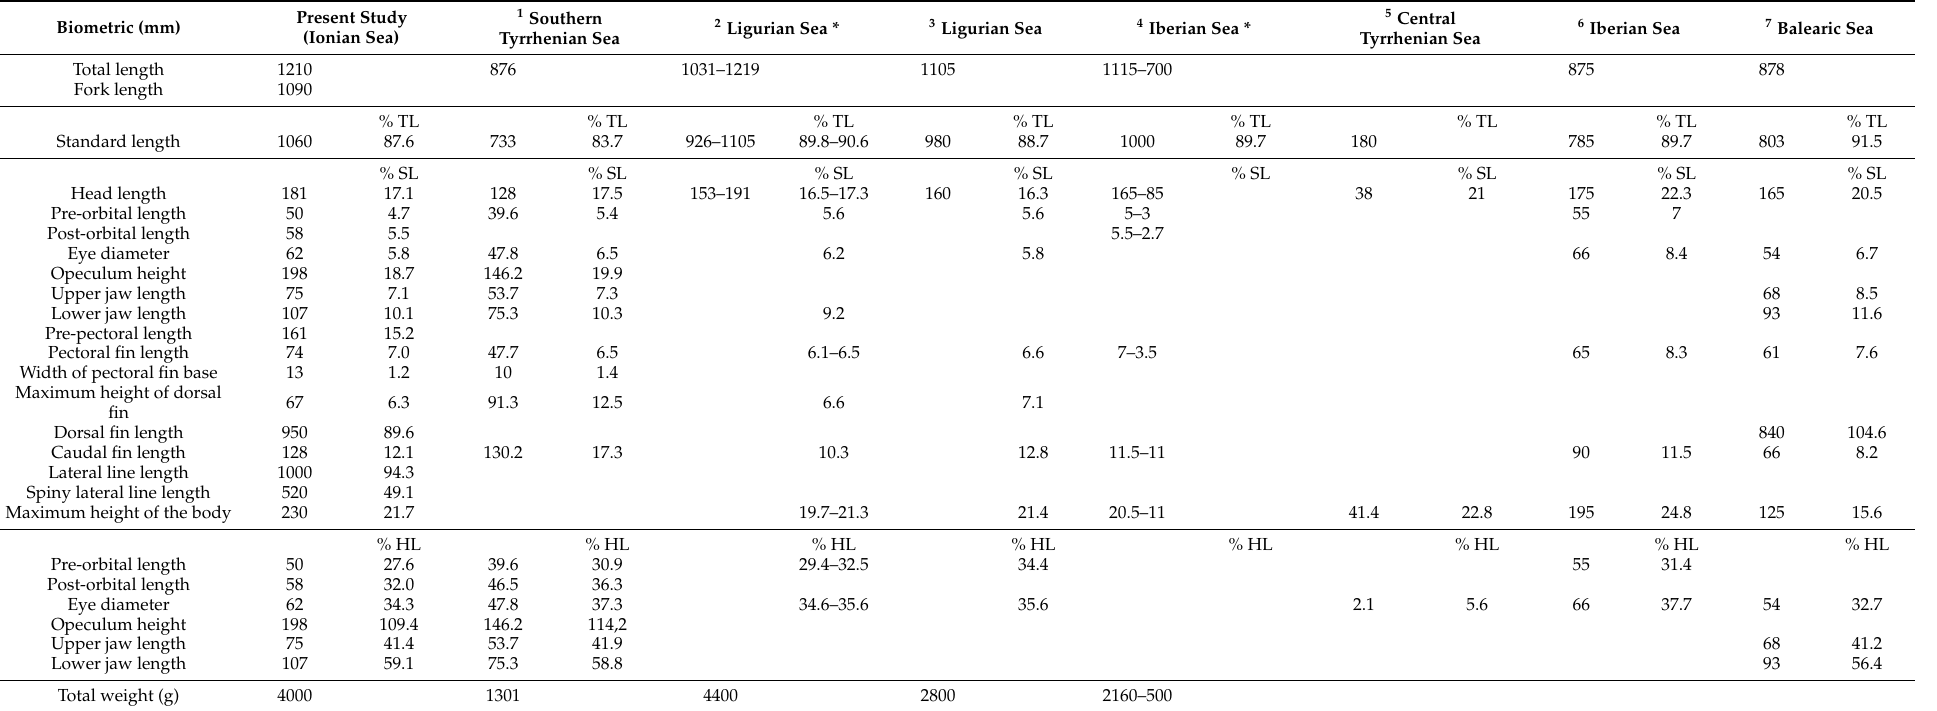
Table 1. Biometric data of the specimen of this study, compared with some Z. cristatus specimens reported with details in the Mediterranean area. 1 Falsone et al., 2017; 2 Psomadakis et al., 2007; 3 Tortonese, 1958; 4 Roig & Demestre, 1982; 5 Bianco et al., 2006; 6 Ibanez & Gallego, 1974; 7 Garcia-Barcelona et al., 2014. % SL was referred to as a percentage of the standard length; % TL was referred to as a percentage of the total length; % HL was referred to as a percentage of the head length. * Identify the studies with two described specimens. The first column numbers all referred to the specimen 1 reported in the study; the second column numbers all referred to specimen 2 reported in the